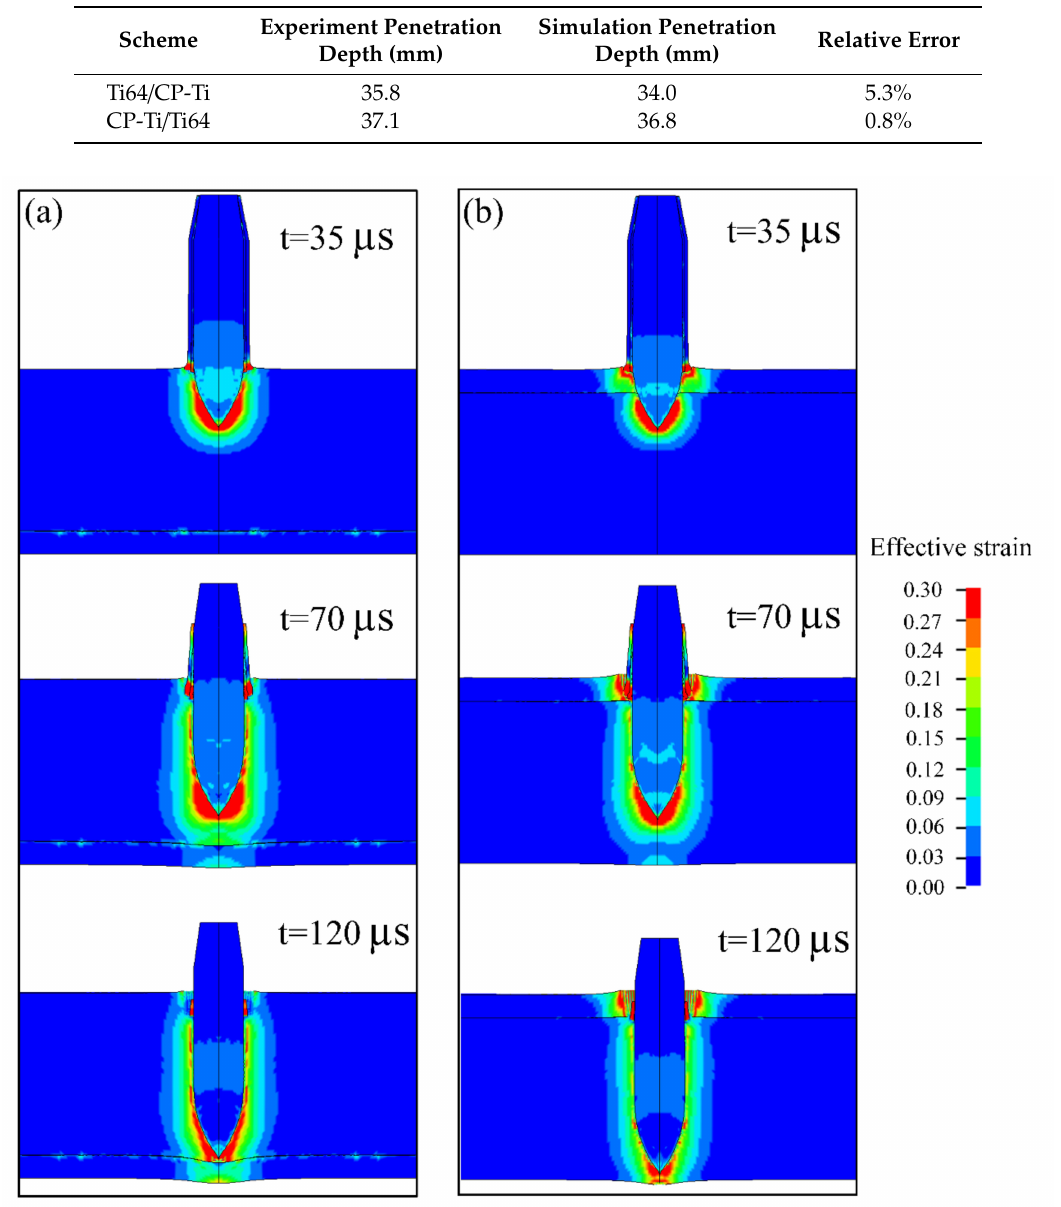
Figure 5. The strain distribution of the projectile and plate during the penetration process: ( a ) Ti64 / CPTi and ( b ) CPTi /